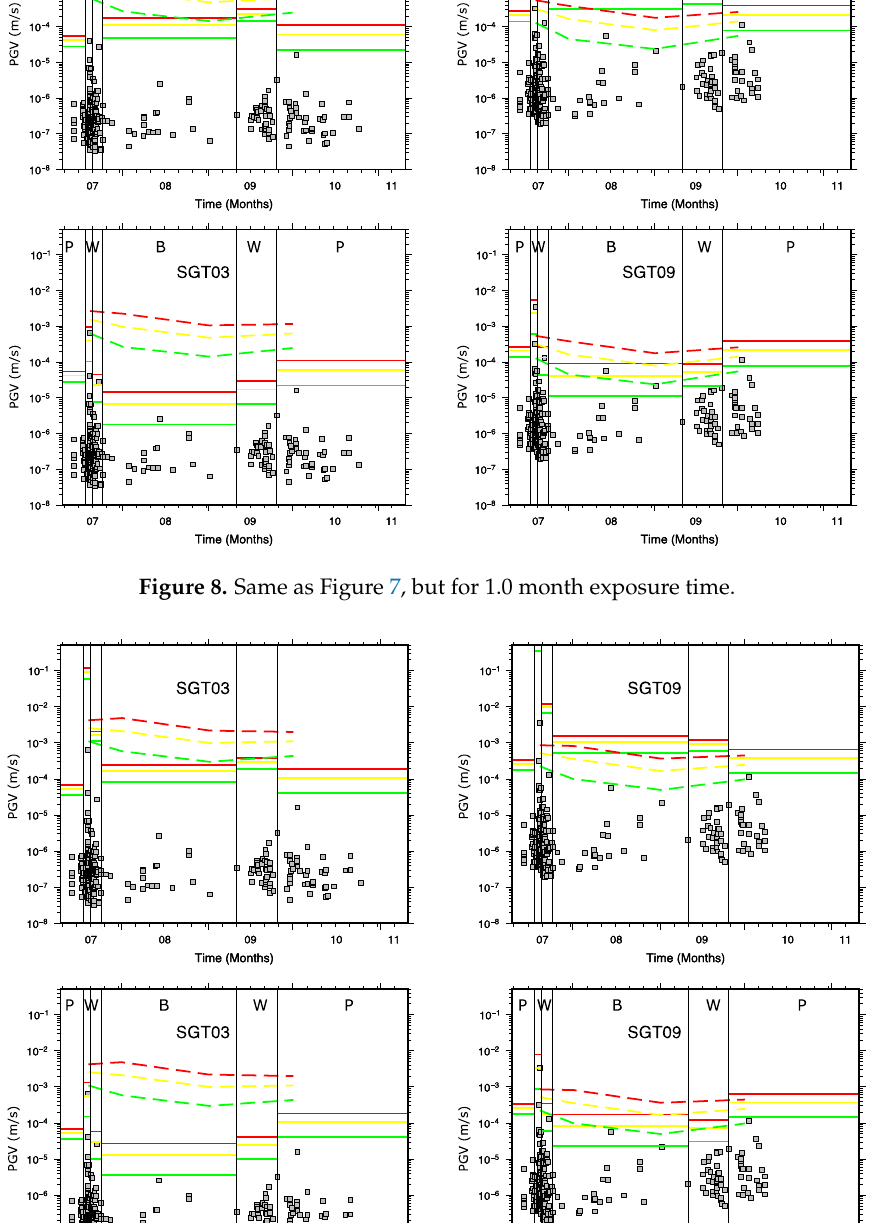
Figure 9. Same as Figure 7, but for 2.0 month exposure time.